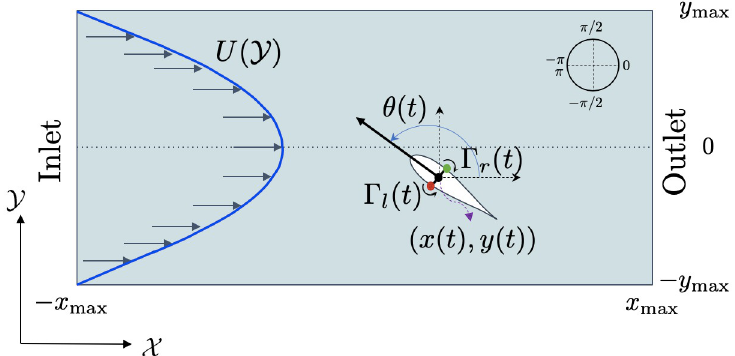
Fig 2. Modeling zebrafish swimming in a flow as a finite-dipole. U ð Y Þ is the profile of the uniaxial background flow. The black dot and arrow denote the fish centroid position ( x ( t ), y ( t )) and heading angle θ ( t ), with respect to the global reference frame ( X ; Y ). The green and red dots represent the left and right location of the vortices of circulation strengths Γ l ( t ) and Γ r ( t ),